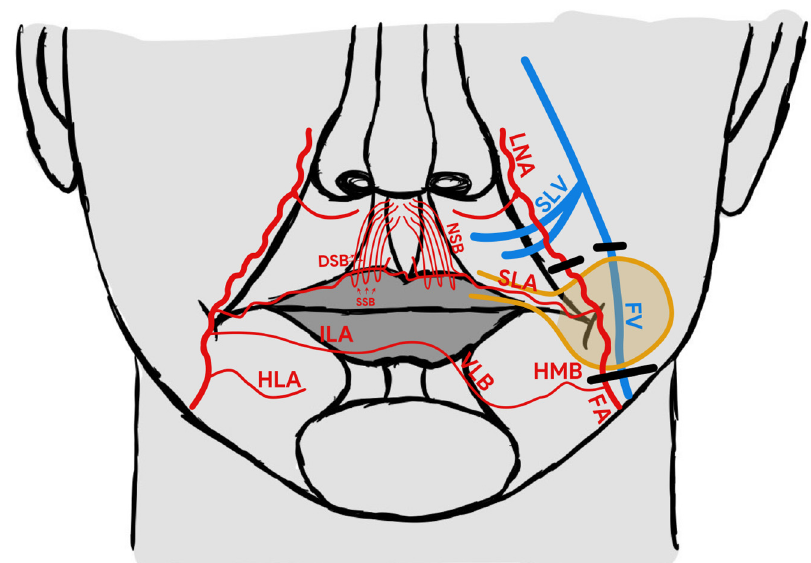
Figure 1. rSLA island flap anatomy. FA—facial artery, FV—facial vein, SLA—superior labial artery, SLV—superior labial vein, ILA—inferior labial artery, LNA—lateral nasal artery, HLA—horizontal labiomental artery, HMB—horizontal mental branch, VLB—vertical labiomental branch, NSB—na- sal septal branches, DSB—deep septal branch, SSB—superficial septal branch. The black line indi- cates the location of the vessels’ ligation.